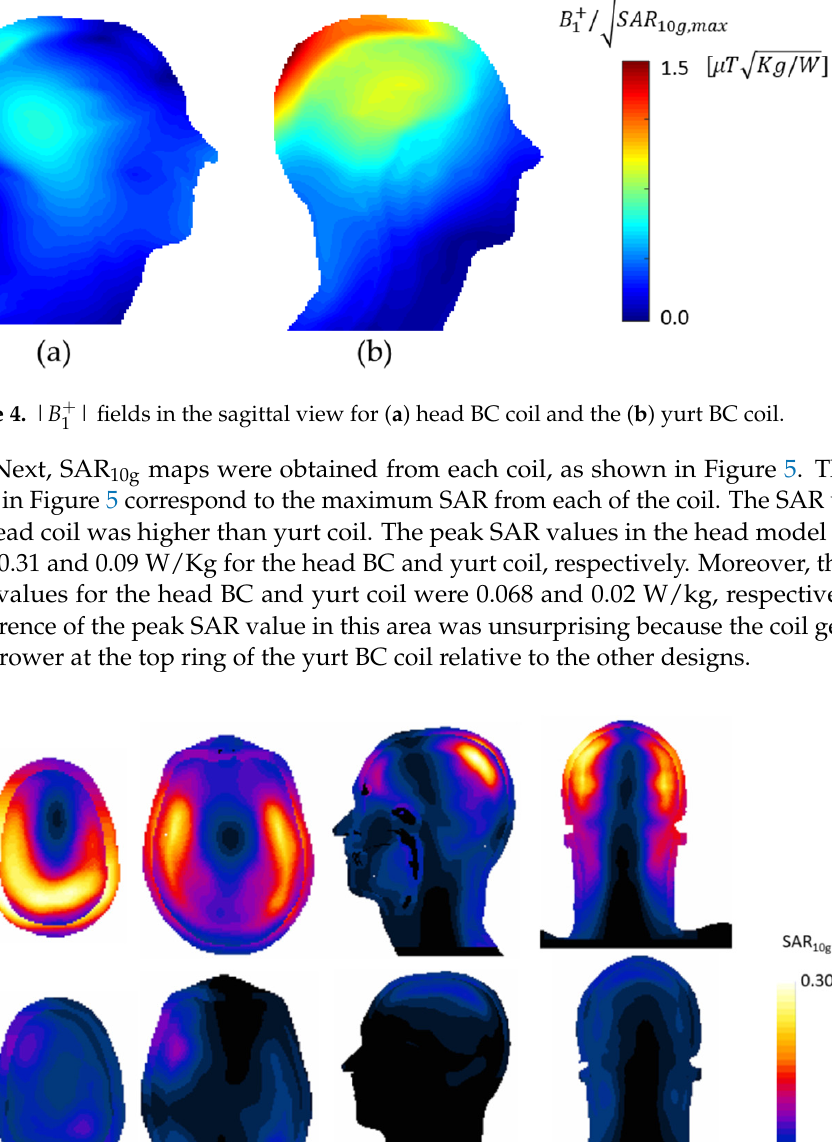
Figure 5. SAR 10g maps in the axial, sagittal, and coronal views of a human model for ( a ) head BC coil and ( b ) yurt BC coil. 4. Discussion